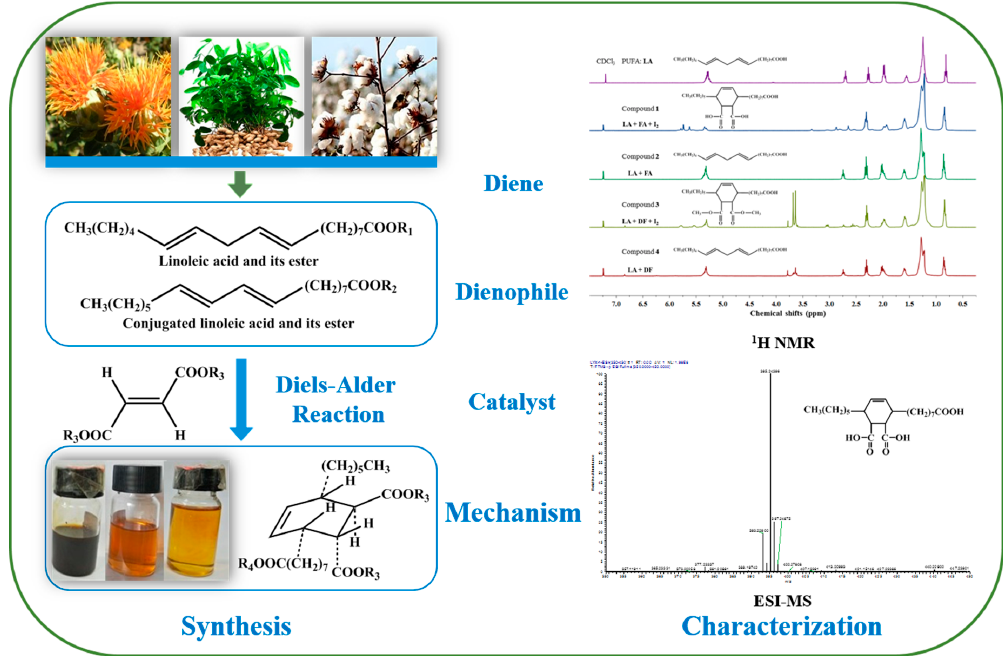
Table of Contents: The Role of Iodine Catalyst in the Synthesis of 22-Carbon Tricarboxylic Acid and Its Ester: A Case Study.